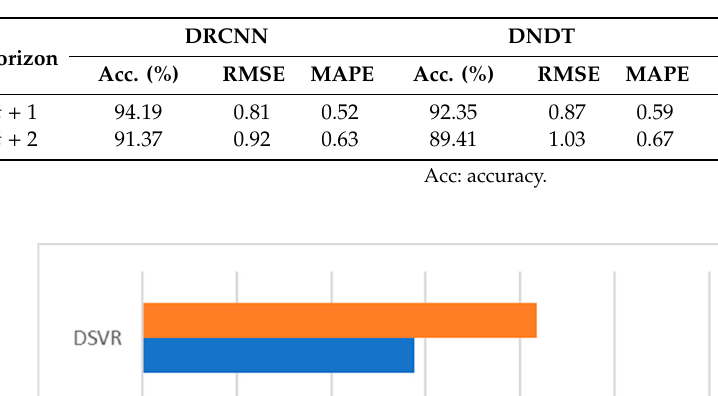
Figure 6. Multiple-step ahead forecasts in forecast horizon: MAPE. 5. Conclusions This study developed a comparison of methodologies to predict Bitcoin price and, therefore, a new model was created to forecast this price. The period selected was from 2011 to 2019. We applied different deep learning methods in the construction of the Bitcoin price prediction model to achieve a robust model, such as deep recurrent convolutional neural network, deep neural decision trees and deep support vector machines. The DRCNN model obtained the highest levels of precision. We propose to increase the level of performance of the models to predict the price of Bitcoin compared to previous literature. This research has shown significantly higher precision results than those shown in previous works, achieving a precision hit range of 92.61–95.27%. Likewise, it was possible to identify a new set of significant variables for the prediction of the price of Bitcoin, offering great stability in the models developed predicting in the future horizons of one and two years. This research allows us to increase the results and conclusions on the price of Bitcoin concerning previous works, both in matters of precision and error, but also on significant variables. A set of significant variables for each methodology applied has been selected analyzing our results, but some of these variables are recurrent in the three methods. This supposes an important addition to the field